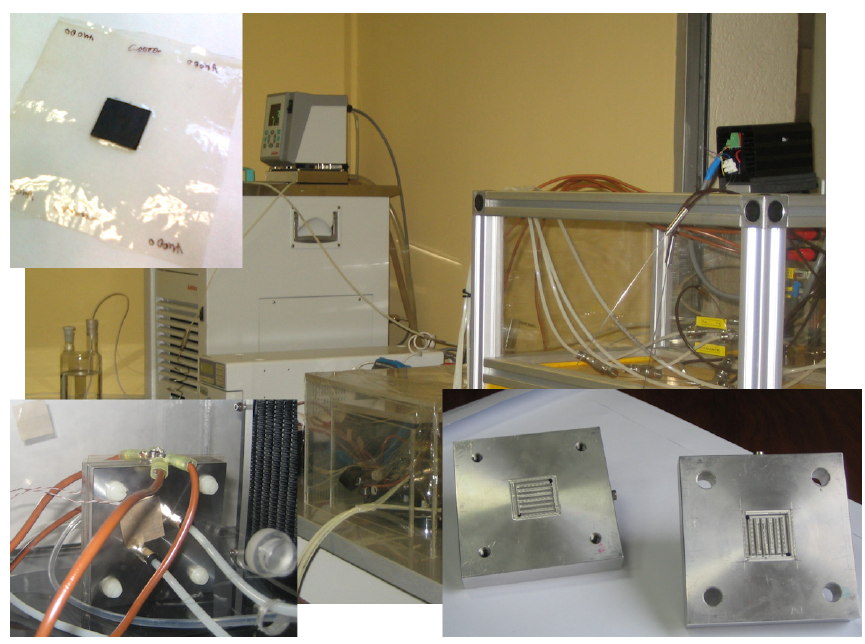
Figure 1. Custom experimental